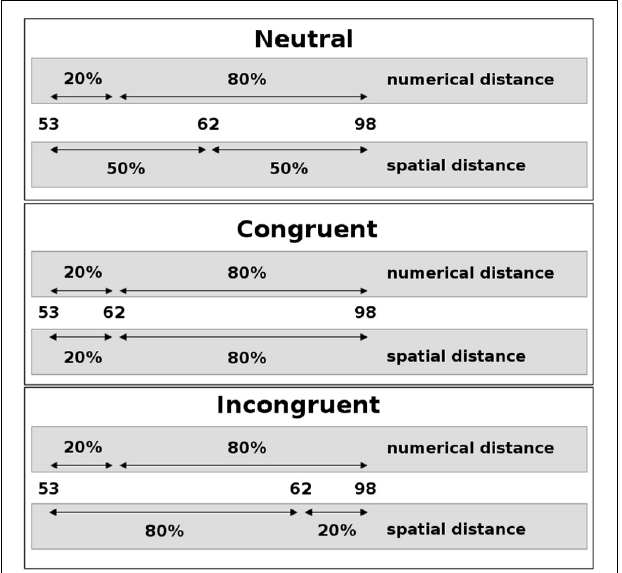
FIGURE 1 | Schematic depiction of the numerical landmark paradigm. The spatial position of the middle number of a number triplet (here: 62) was varied such that the spatial intervals to the outer numbers (here: 53 and 98) could be neutral (top), congruent (middle), or incongruent (bottom) with the respective numerical intervals. Percentages relate the respective intervals to the size of the interval between the outer numbers. Participants were asked to decide which side the smaller numerical interval is